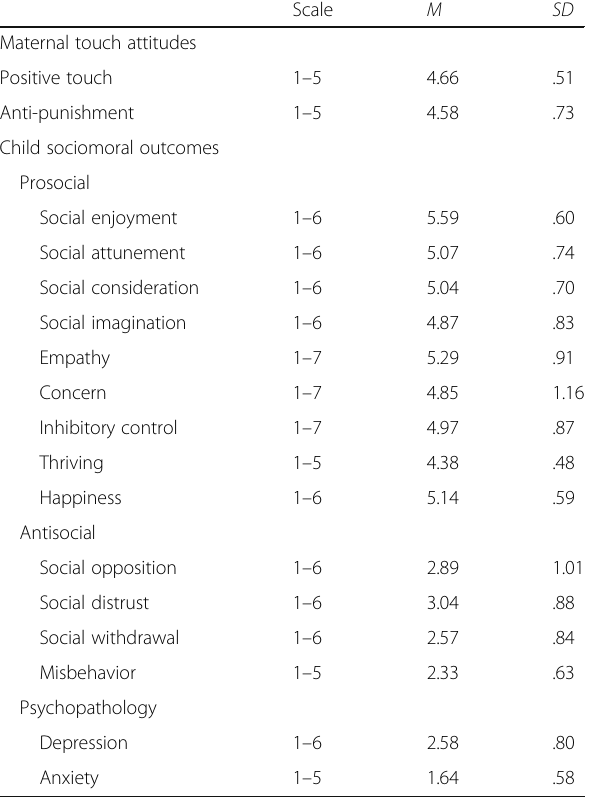
Table 1 Study 1 scales, means, and standard deviations ( N = 156)